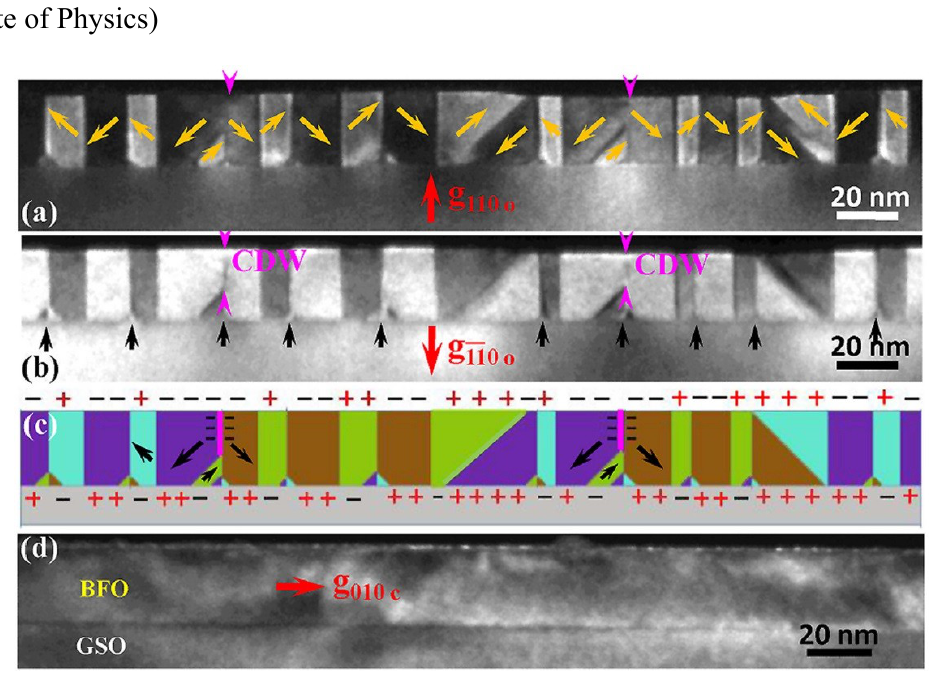
and ( b ) g = ; 0 zone o